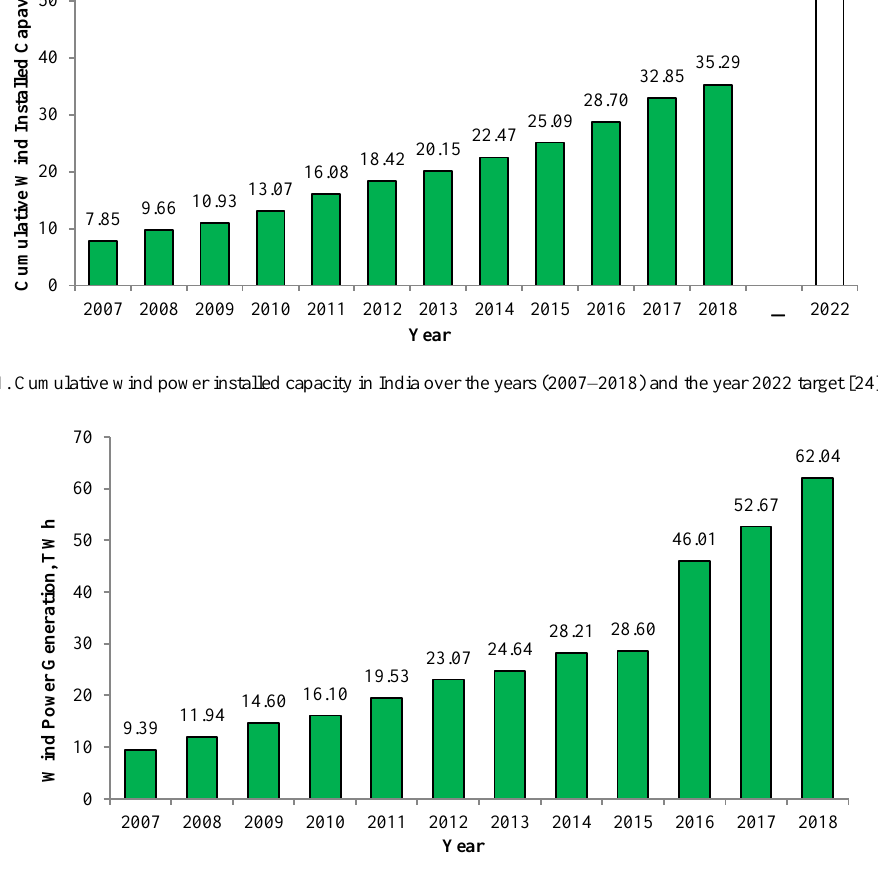
Fig. 2. Annual wind power generation in India over the years (2007–2018) [24],